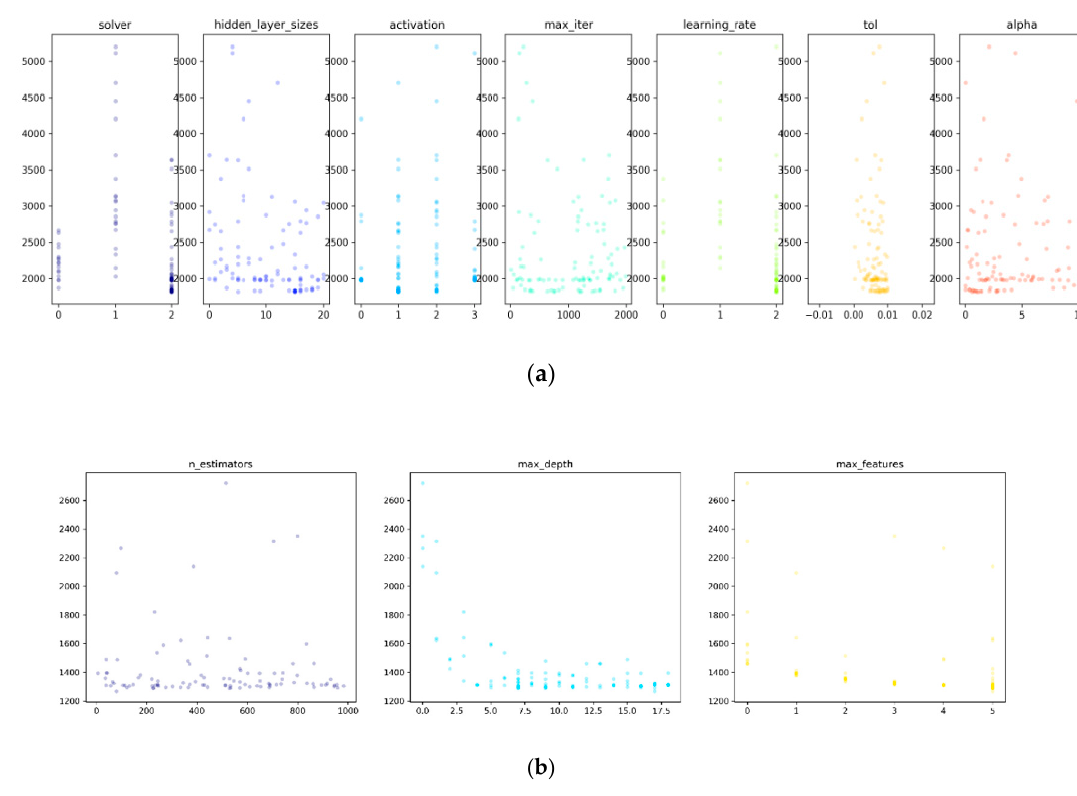
Figure A1. Bayesian hyper-parameter optimization process of ( a )MLP and ( b )RF ensemble modelling.